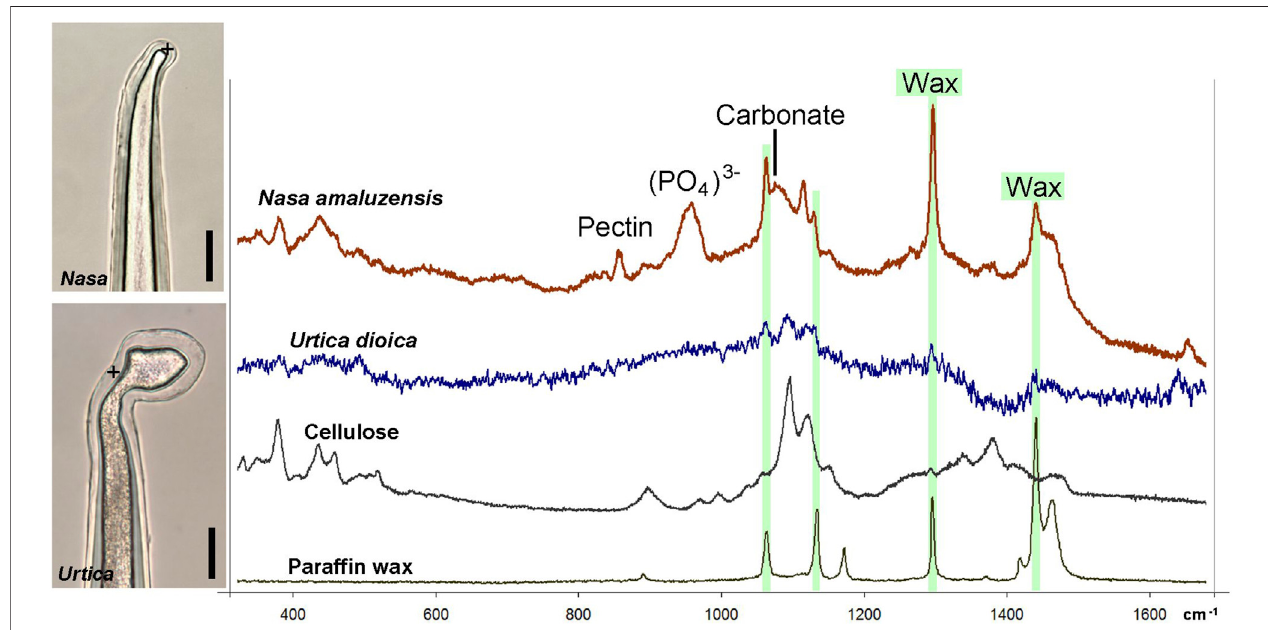
FIGURE8| Ramanspectraofapicesoflivingstinginghairsof Nasaamaluzensis and Urticadioica .Spectraofcelluloseandparaf fi nwaxareshownforcomparison. Leaf stalks with stinging hairs were immersed in water. Spectrum for the Nasa stinging hair tip clearly shows Raman bands of cellulose, pectin, phosphate, and a small carbonate peak which overlaps with the cellulose peak. Several sharp peaks indicate crystalline wax (highlighted in green). The spectrum of Urtica shows only traces of cellulose and wax bands. Scale bars: 10 µm.